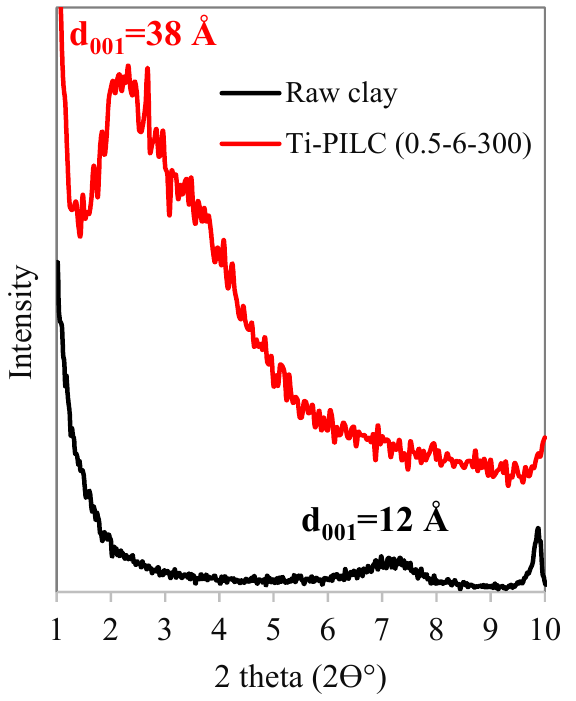
14 of 20 Figure 10. Different possibilities in the introduction of TiO 2 particles into the raw clay layered texture. 4.4. XRD and XRF Analysis In order to prove the role of TiO 2 introduction as a pillaring agent, the low-angle XRD analysis at 2 θ = 1–12° was performed on the raw clay, and Ti-PILC has the highest S BET (0.5-6-300); the patterns are shown in Figure 11. It can be observed that the raw clay has